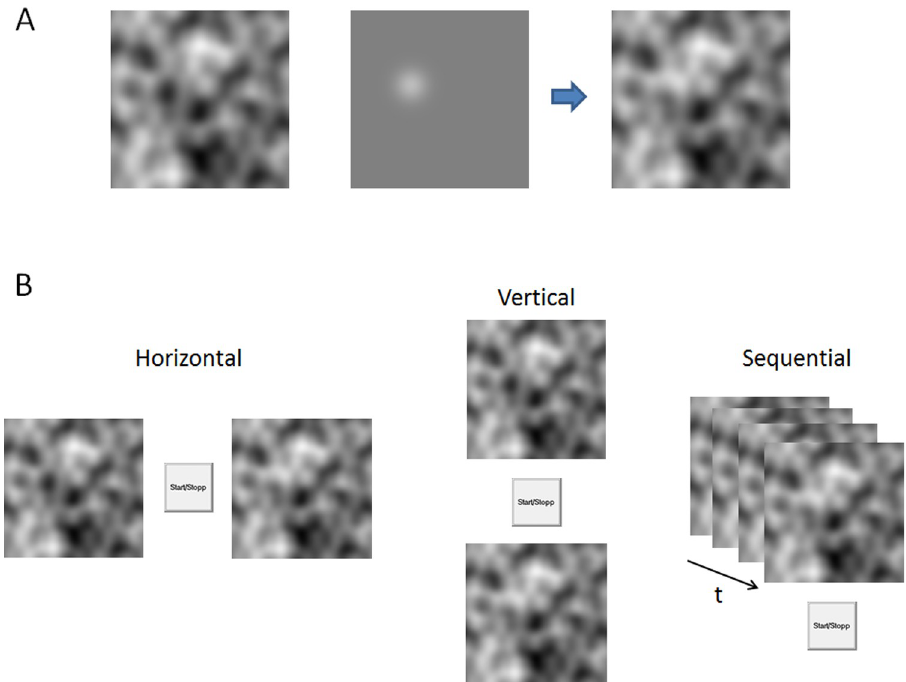
Fig 1. Stimulus and presentation formats. (A) An example of a Perlin pattern on the left, and a randomly positioned Gaussian blob superimposed on a homogenous background in the middle. To create the stimuli pairs the blob was added to the Perlin pattern as shown in the rightmost image. (B) Illustration of the different conditions with the response button and the image pairs separated horizontally, vertically, and overlaid with repeated sequential presentation over time t. In the two sequential conditions each image was then presented 400 milliseconds with ISI (inter stimulus intervals) = 0 or ISI = 200 milliseconds. in radiological images, such as intraparenchymal metastases in a computed tomography image. Briefly, these patterns are created by defining a grid of random gradient vectors at the corners of each square grid covering the stimulus area. Then the dot product between the gra- dient vectors and their offsets to each pixel within the grid square are computed, and finally these values are smoothly interpolated to obtain the luminance value at that pixel. For the pres- ent purpose 30 square shaped images were created, each with a side 8.7 cm. Each image con- tained a 3 x 3 grid to determine the locations of the random vectors. The original Perlin algorithm produce some images with directional artefacts, these were visually sorted out. An example of a resulting Perlin noise image is demonstrated in the leftmost image in Fig 1A. The 30 images were doubled to create identical pairs, and to one of the images in a pair a randomly located target deviation was added. The target was created by adding a 2D Gaussian luminance distribution to the Perlin image. The Gaussian had a width σ = 3.5 mm resulting in a visible deviation between otherwise identical image pairs (the target) with a diameter about 2 cm. If the luminance of the Perlin pattern at the location of the target was lower than the aver- age luminance (R = G = B = 128) then a target with positive contrast was added (otherwise a negative contrast with negative luminance values of the target was added) to create each stimu- lus pair. All images were also visually inspected to make sure that the target was undetectable from any image alone. The middle image in Fig 1A shows an example of a target with positive contrast added to a homogenous luminance field (the grey field has R, G, B values set to 128, which is the same as the average luminance across the Perlin noise images). The rightmost image is the result of adding the target to the Perlin image.